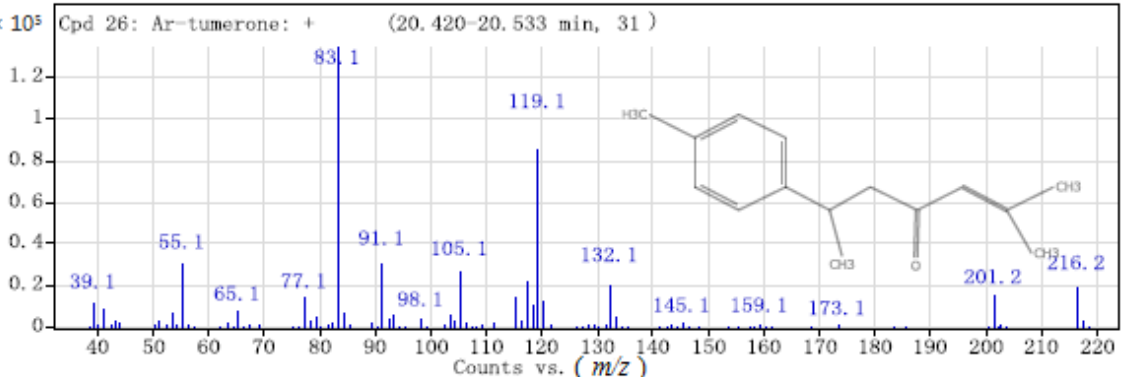
Figure 4. Mass spectrum of ar-turmerone.